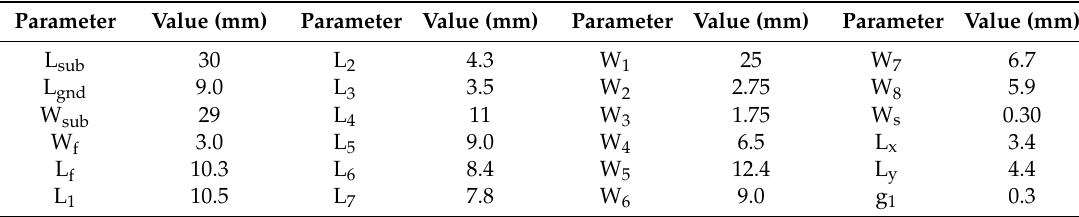
Figure 2. Prototype of the reference and proposed antenna. ( a ) The reference antenna (front view); ( b ) the proposed antenna (front view); and ( c ) the reference and proposed antenna (rear view). Table 1. Dimensions of the reference and proposed antennas.